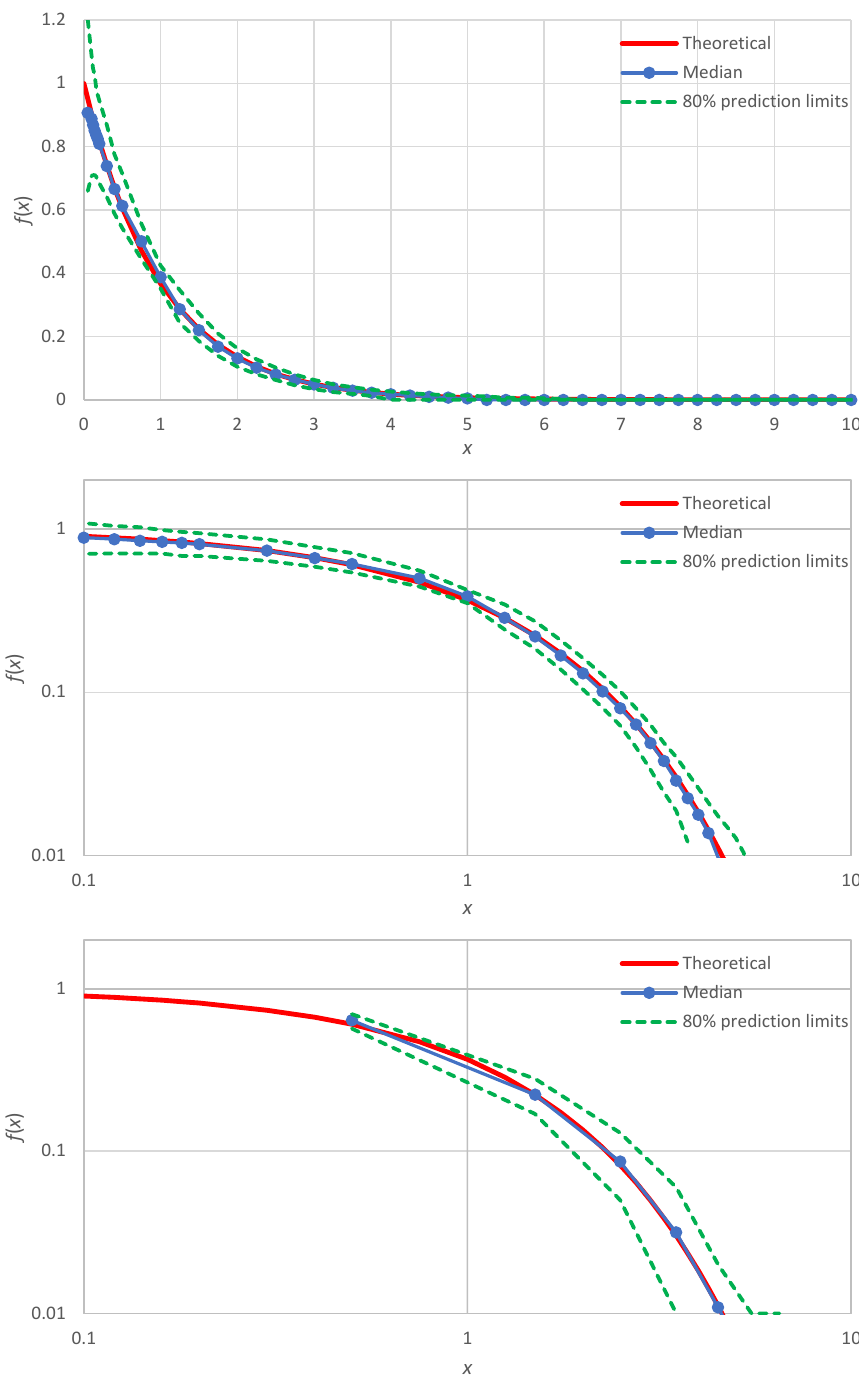
Figure 2. Illustration of the median estimate and uncertainty (in terms of prediction limits) of the probability density using the proposed method, plotted in Cartesian ( upper ) and logarithmic ( middle ) axes. The original results from the proposed method are interpolated at the points that are plotted in the graphs. For comparison, results for the classical histogram with 10 bins are also shown ( lower ), plotted with abscissae equal to the midpoints of the bins. The true distribution is exponential with parameters as in Table 4, from which 100 data series of 𝑛 = 100 values each were generated and processed to produce the uncertainty band.